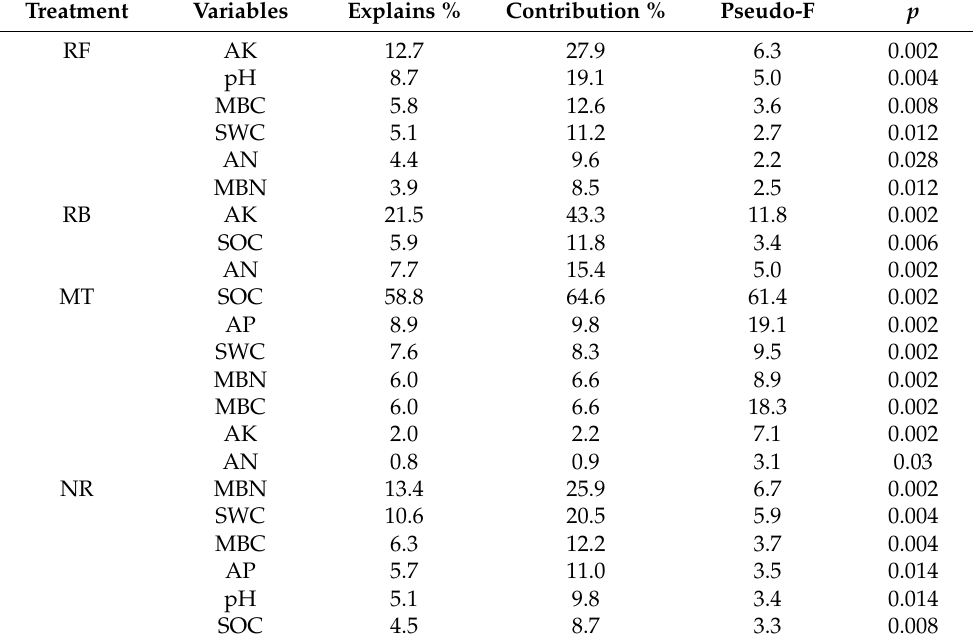
Table A4. Explanatory rate and contribution rate of soil environmental factors to the change in soil microbial carbon source metabolic